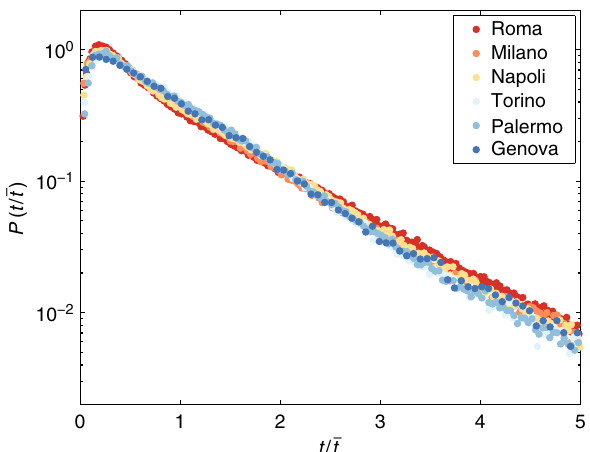
Figure 1 | Travel time distribution in the six largest Italian cities. The probability distribution P ( t ) is well fitted by an exponential function. As demonstrated by the data collapse shown here, differences among cities are encoded in a single parameter: the average travel time (cid:2) t .